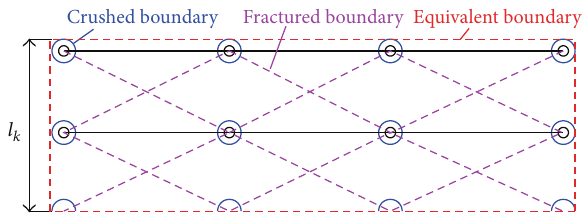
Figure 3: Equivalent boundary of other